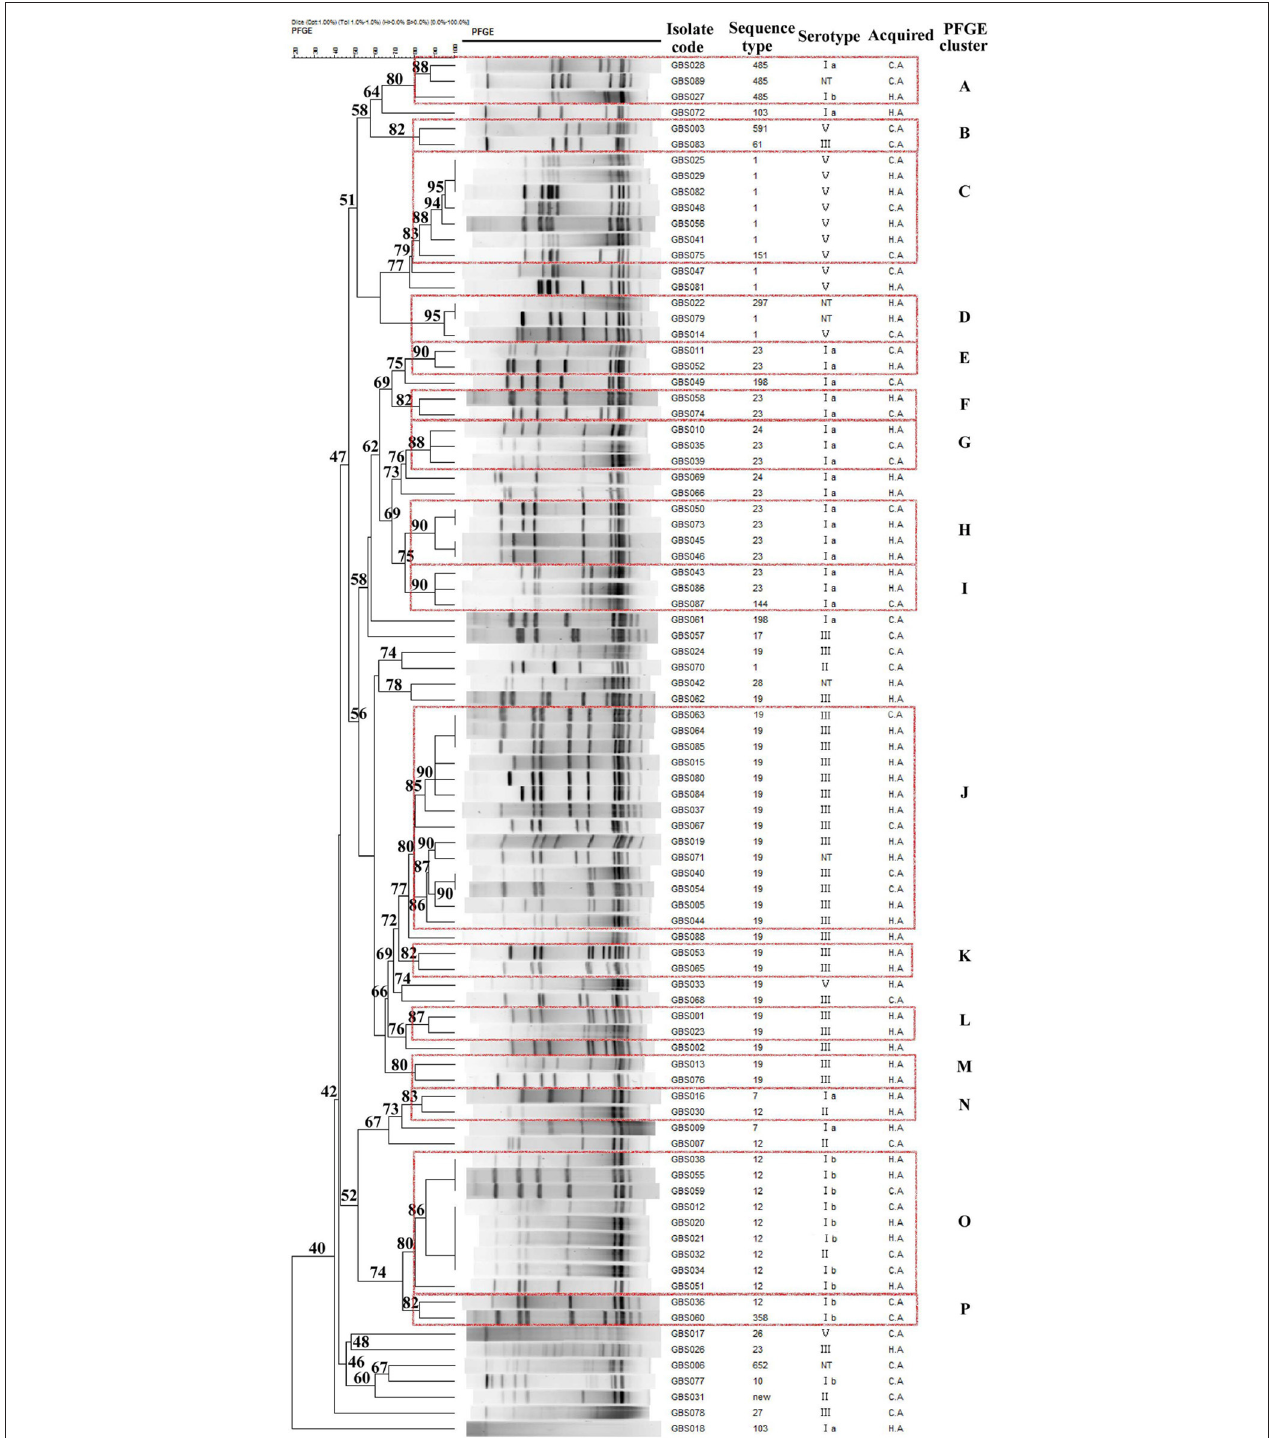
FIGURE 2 | Dendrogram of the PFGE profiles of 87 GBS isolates. The dendrogram was constructed using the UPGMA method. Dice coefficients (percentages) are indicated in the scale above the dendrogram. Each cluster (defined as a group of two or more isolates with a Dice coefficient of ≥ 80%) is represented in the